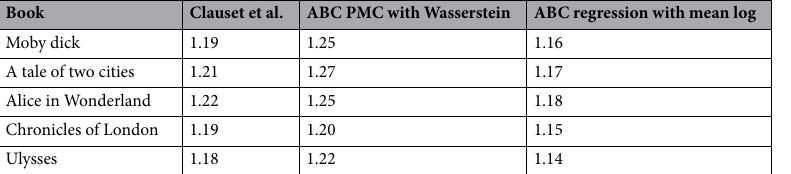
Table 1. Comparision of estimators of Zipf’s law in